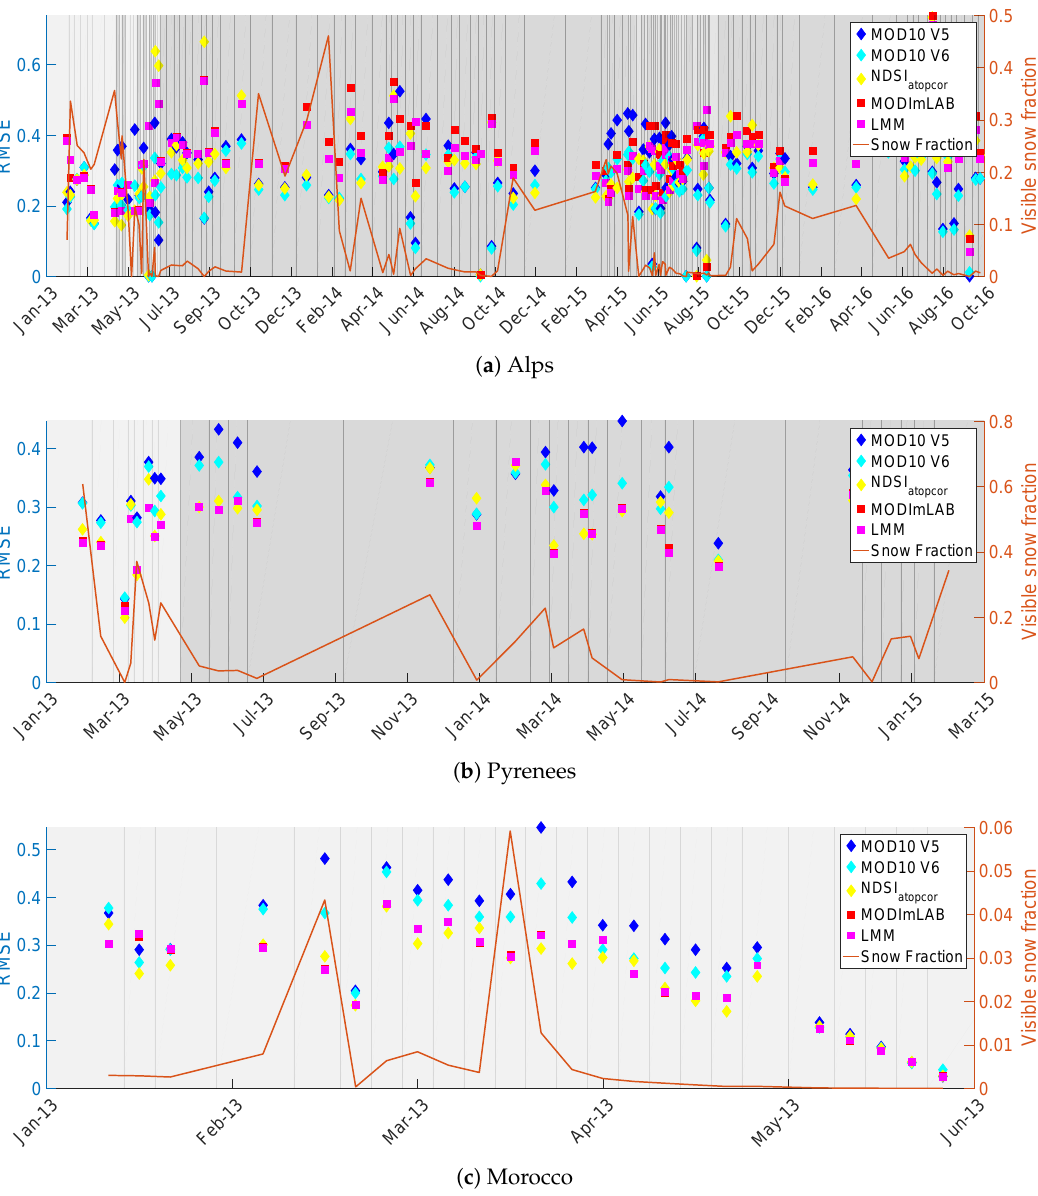
Figure 4. Total snow cover fraction (orange line) and RMSE (markers) for snow-covered and non-cloudy pixels only (RMSE snow ), over the Alps ( a ), Pyrenees ( b ), and Moroccan Atlas ( c ), as a function of all the available dates in each area. Square markers represent SU approaches and the diamond-shaped markers NDSI approaches. The color of the background corresponds to the sensor used as reference. The lighter grey represents SPOT 4, the medium grey SPOT 5, and the darker grey